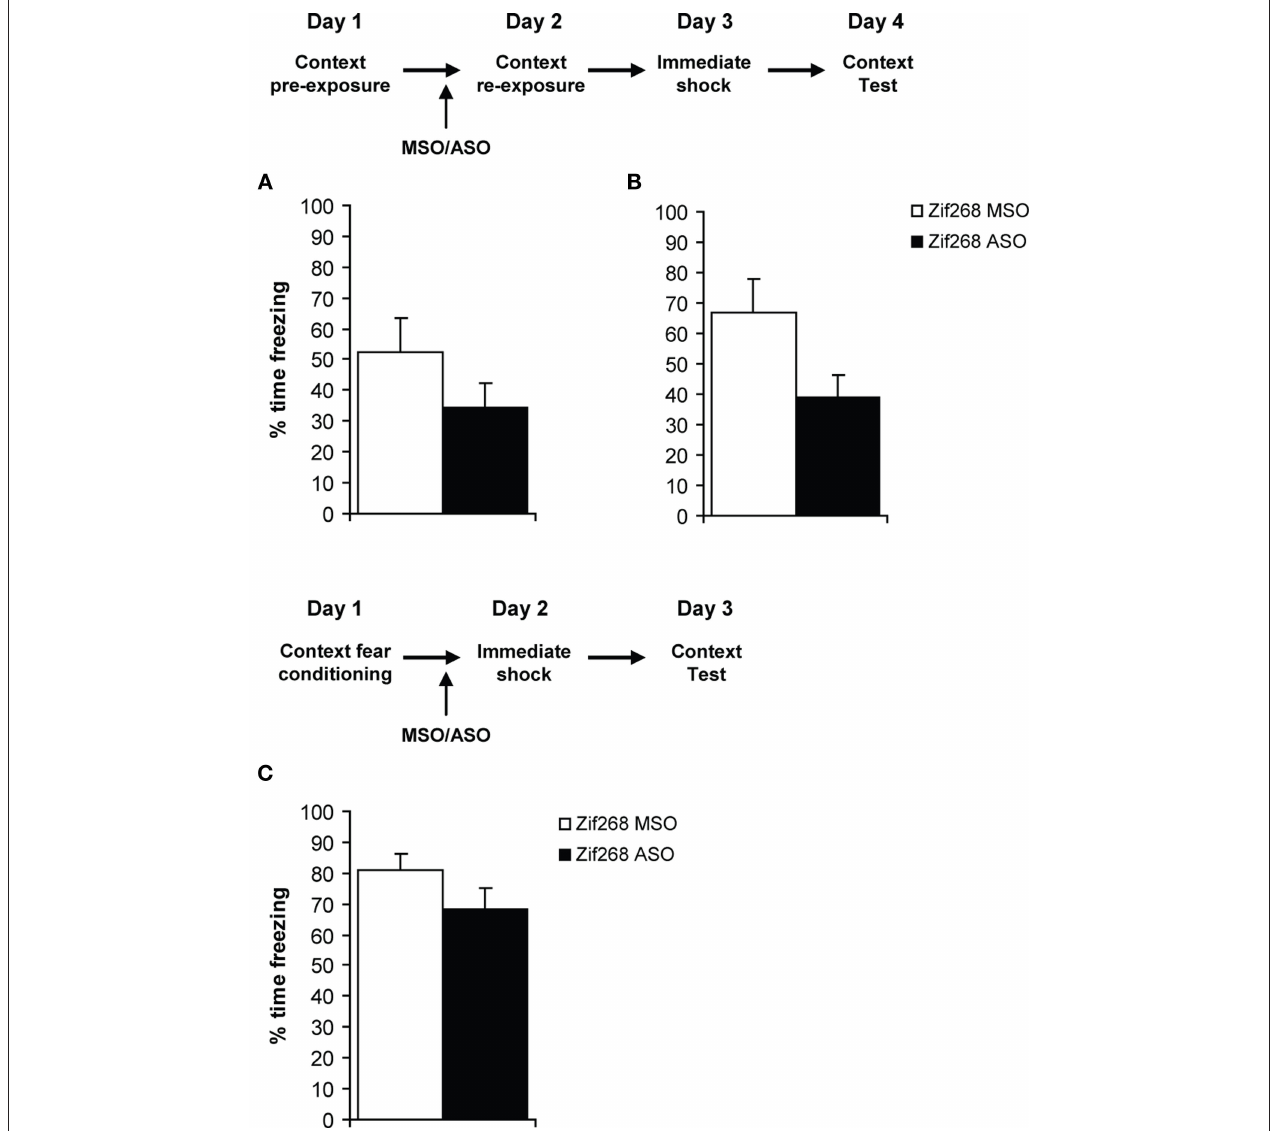
ability of a footshock to be associated with the retrieved memory of the context ( n = 5–6 per group). (C) Rats were given a footshock at the end of each pre-exposure to the context, and then Zif268 was knocked down during a subsequent immediate shock session. No effect was observed in the subsequent context fear memory test ( n = 5–6 per group). Data presented as mean +